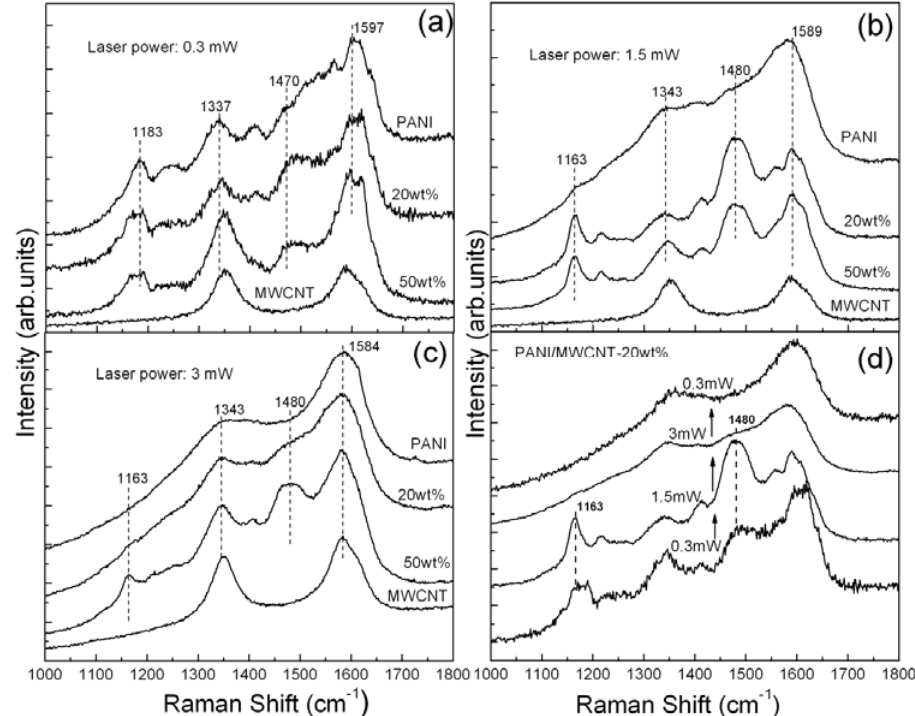
Figure 3. Raman spectra of nf-PANI, nf-PANI/MWCNT-20wt%, nf-PANI/MWCNT-50wt%, and MWCNT collected with 514 nm wavelength laser line at different powers of ( a ) 0.3; ( b ) 1.5 and ( c ) 3mW, respectively; ( d ) Raman spectra of nf-PANI/MWCNT-20wt% obtained on a fixed spot with variable laser power from 0.3 mW to 3 mW and subsequently back to 0.3